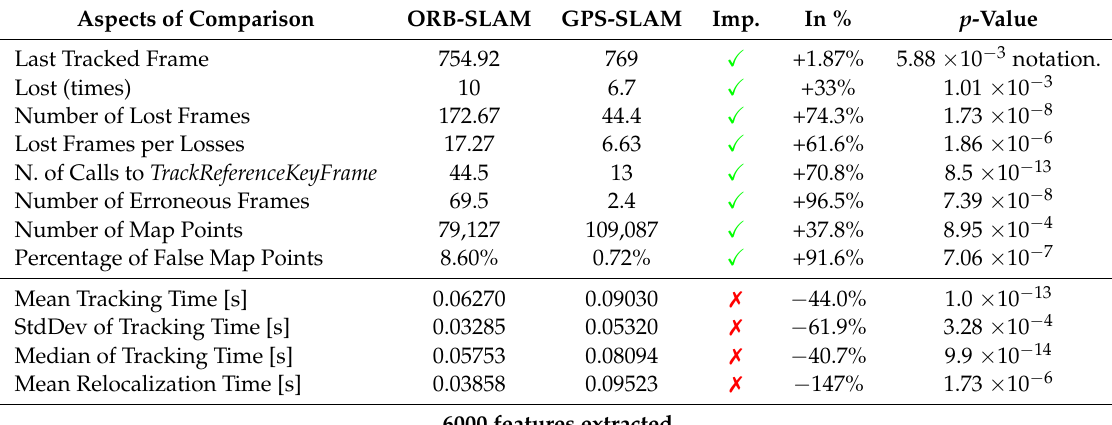
Table 2. The average of the extracted data from 10 runs of each algorithm made with 6000 features. Aspects of Comparison ORB-SLAM GPS-SLAM Imp. p -Value